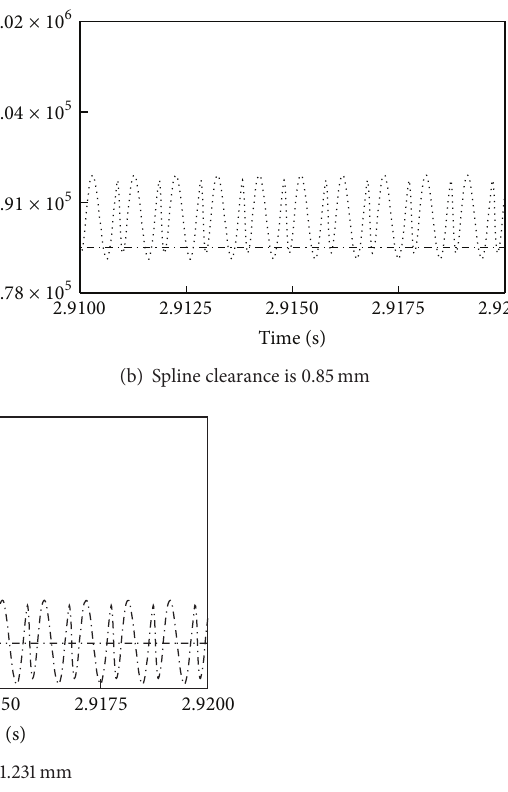
Figure 15: Dynamic load under the influence of the spline